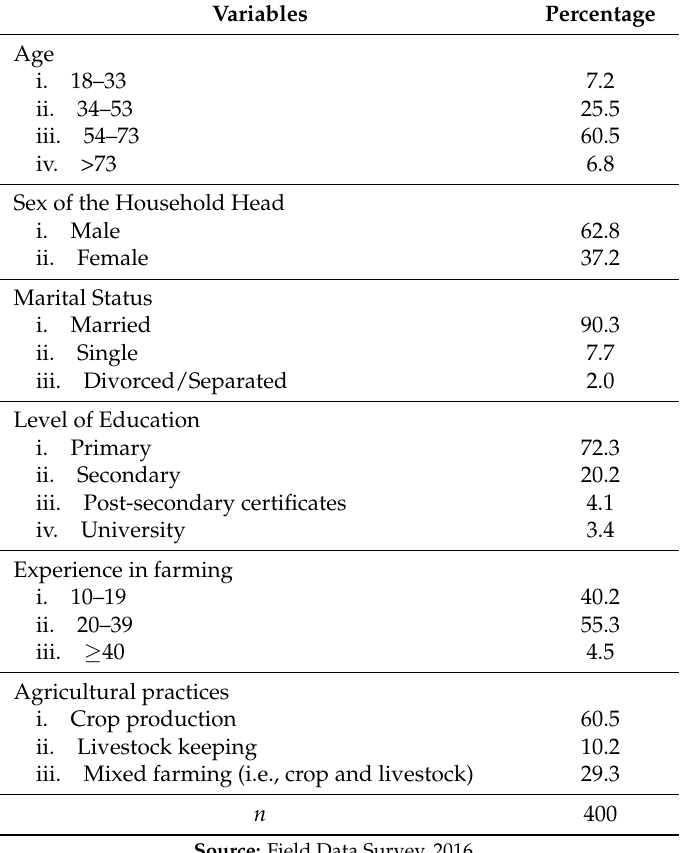
Table 3. Demographic and Farming Characteristics if Respondents in the Sampled